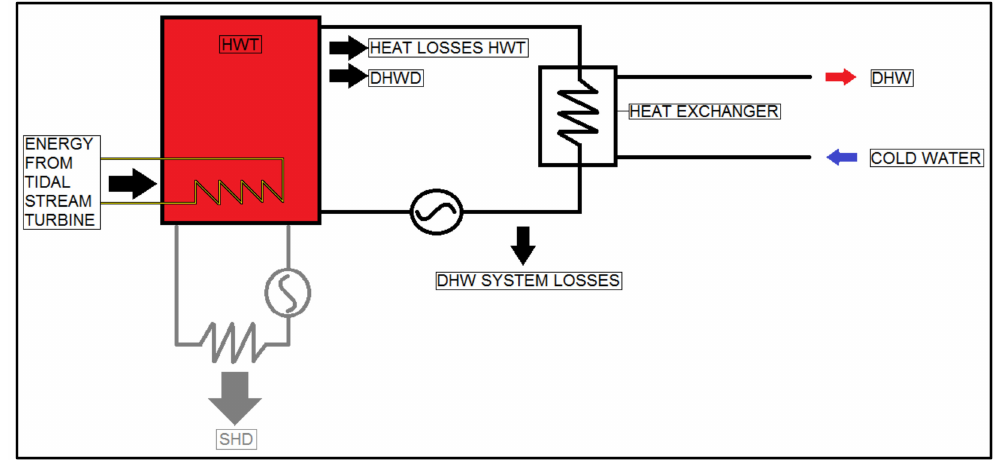
Figure 8. Schematic representation of the systems modelled. In grey is indicated the space heating (SH) branch, only considered in the third scenario. Black and grey arrows indicate energy